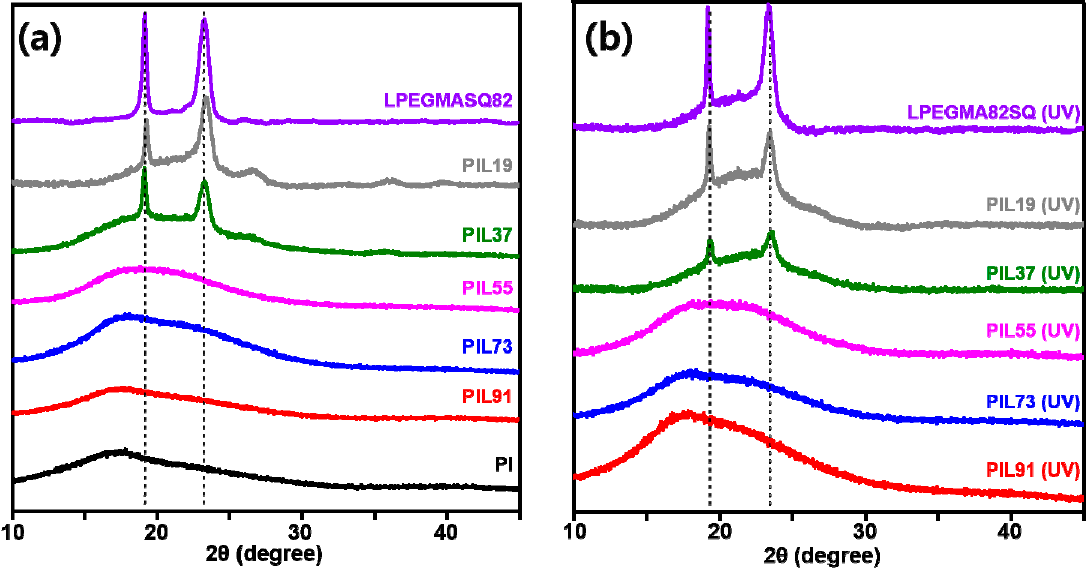
Figure 5. XRD spectra of hybrid composites: ( a ) before UV-curing and ( b ) after UV-curing.